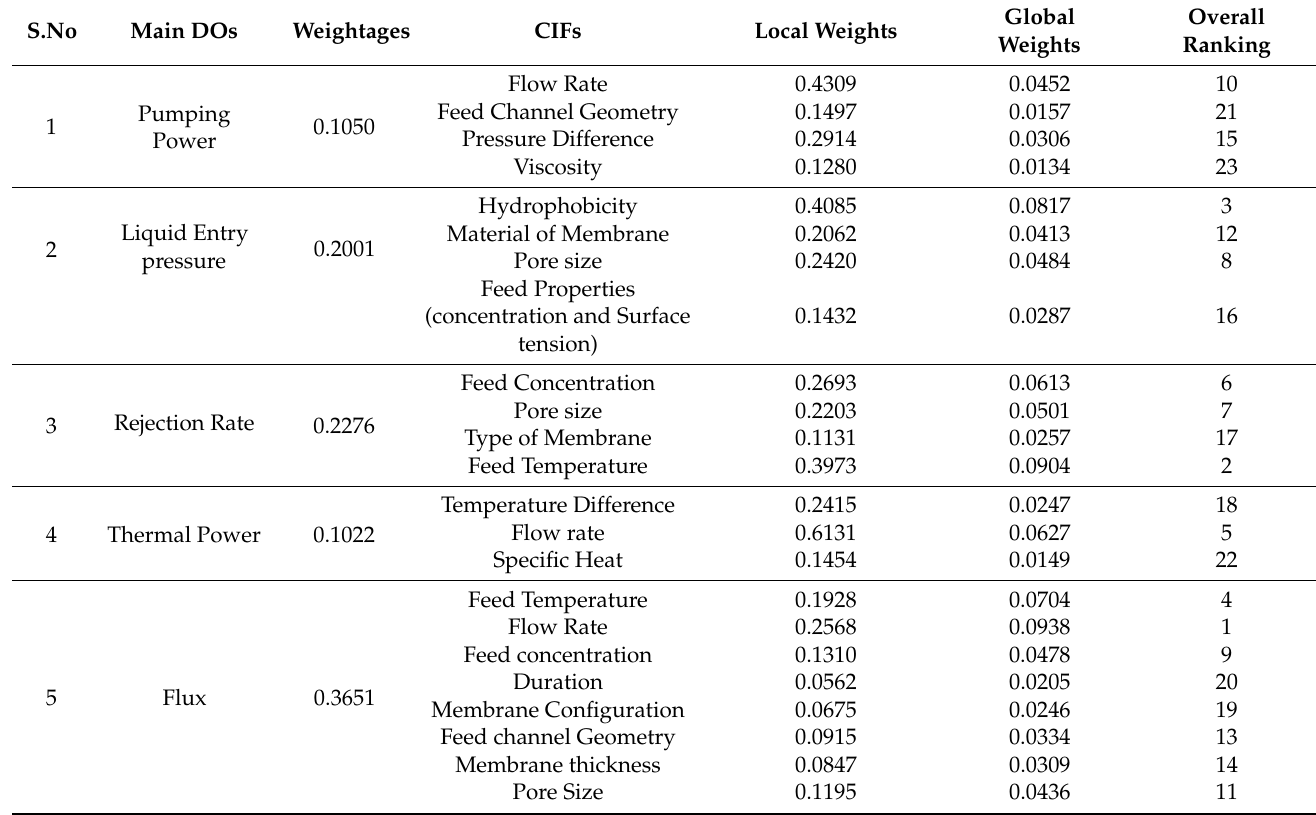
Table 8. Composite weightages of CIFs of MD by using